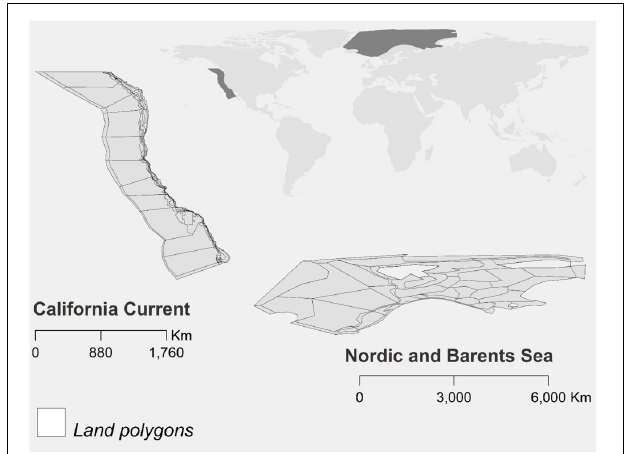
FIGURE 1 | Atlantis model domains for California Current and Nordic and Barents